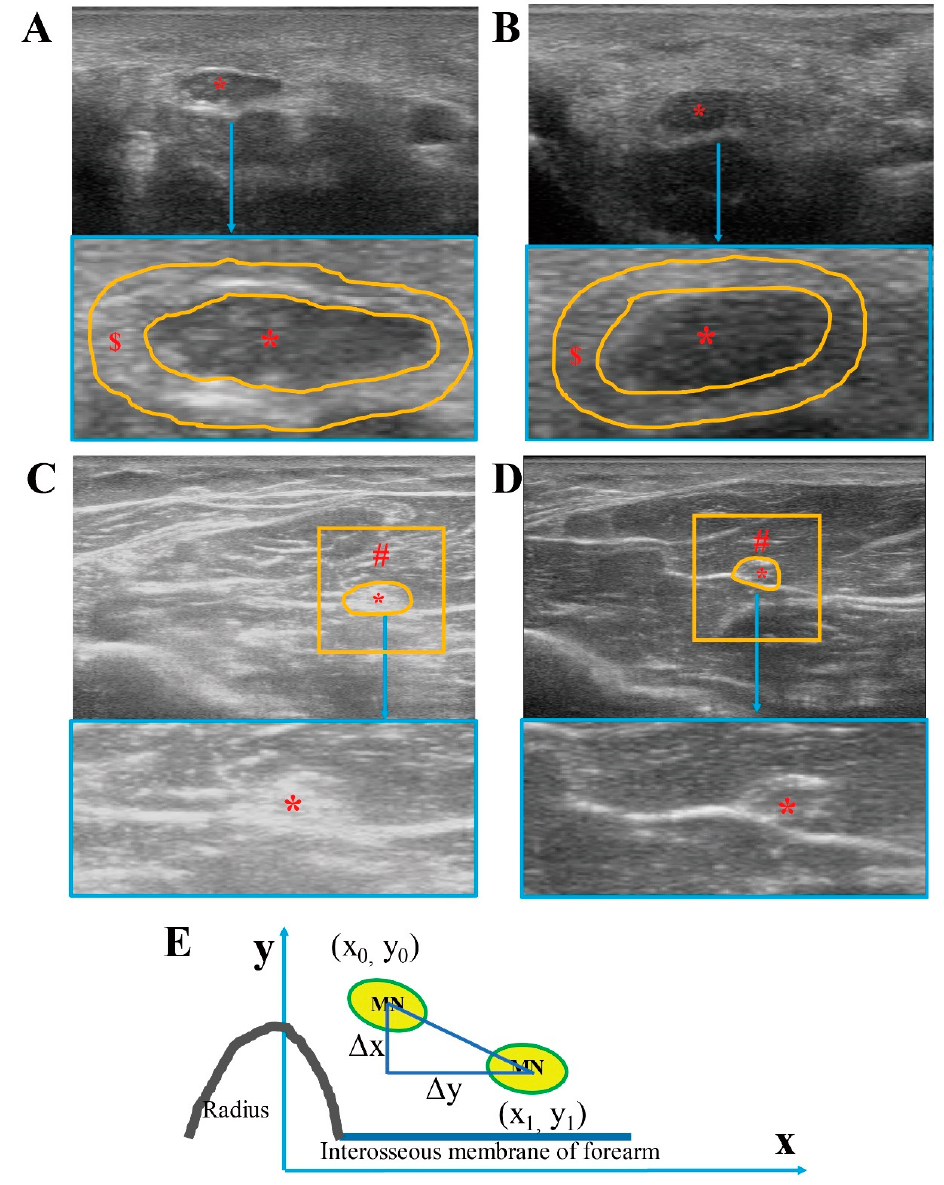
Figure 1. Ultrasound images of median nerve and surrounding tissue. Ultrasound images from CTS subjects at carpal tunnel ( A ) and at mid-forearm ( C ). Ultrasound images from healthy controls at carpal tunnel ( B ) and at mid-forearm ( D ). MN displacement was measured at mid-forearm as the difference between the centroid coordinates (cid:3493)(cid:4666)Δx (cid:2879)(cid:2870) Δy (cid:2870) (cid:4667) ( E ). * = median nerve, $ = paraneural area (PA) indicated by the orange line in A, B, # = region of interest myofascial structure around the median nerve (1 cm 2 ) except the median nerve and paraneural area.